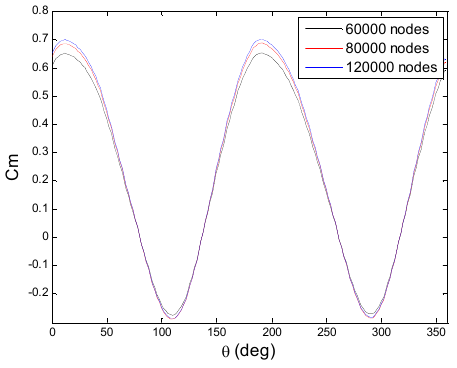
Figure 5. Results for grid